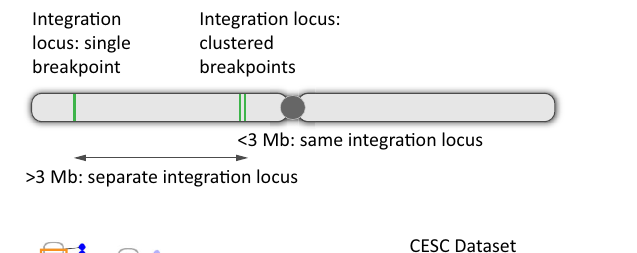
progression. Transcriptionally silent HPV integration loci can be considered to be passenger sites 37 . To identify driver versus passenger integrations, the transcriptional activity of each integration locus was determined for the subset of samples that had matched RNA sequencing data (CESC, n = 144; HNSCC, n =